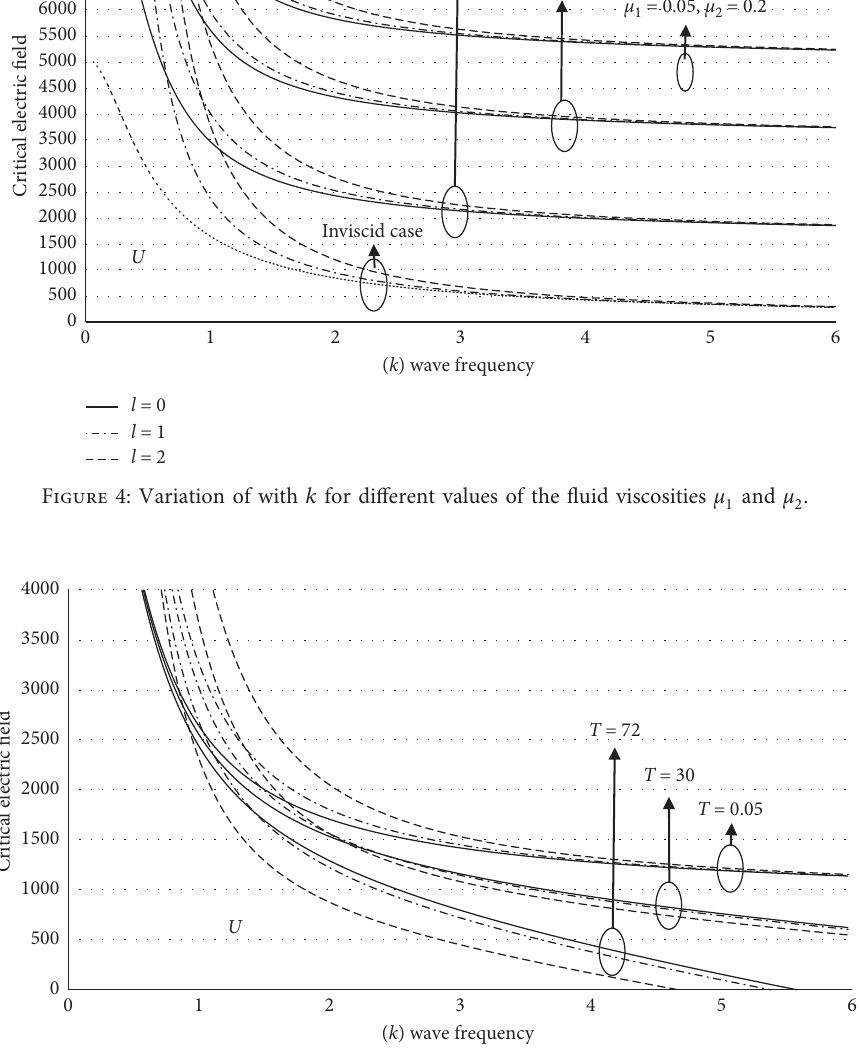
Figure 5: Variation of E 2 with k for different values of the surface tension T 0